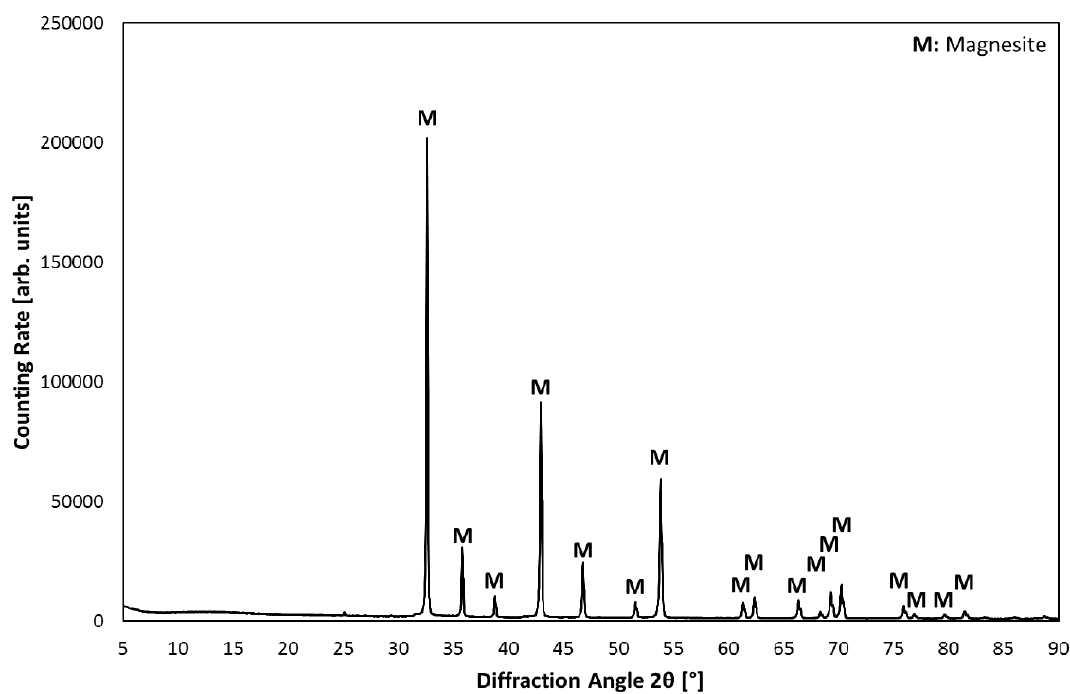
Figure 6. XRD analysis of reference sample after carbonation process.